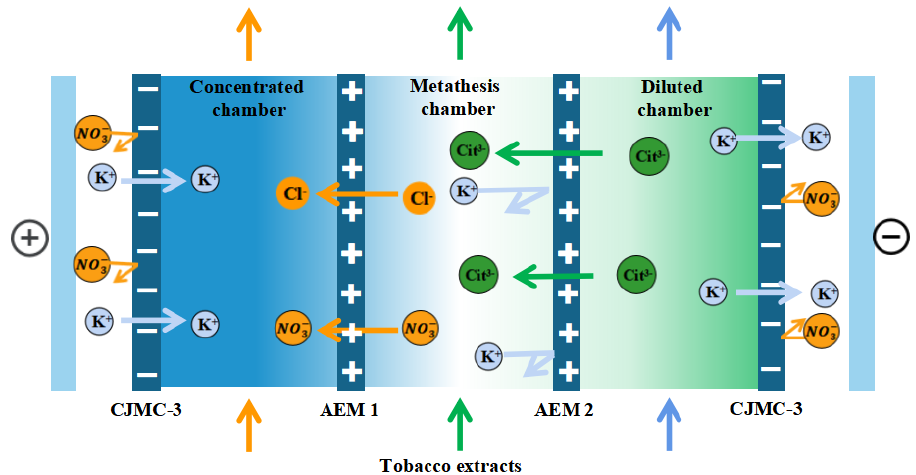
Figure 2. Schematic diagram of electrodialysis–metathesis process for selective remove of anions from tobacco extracts liquid.